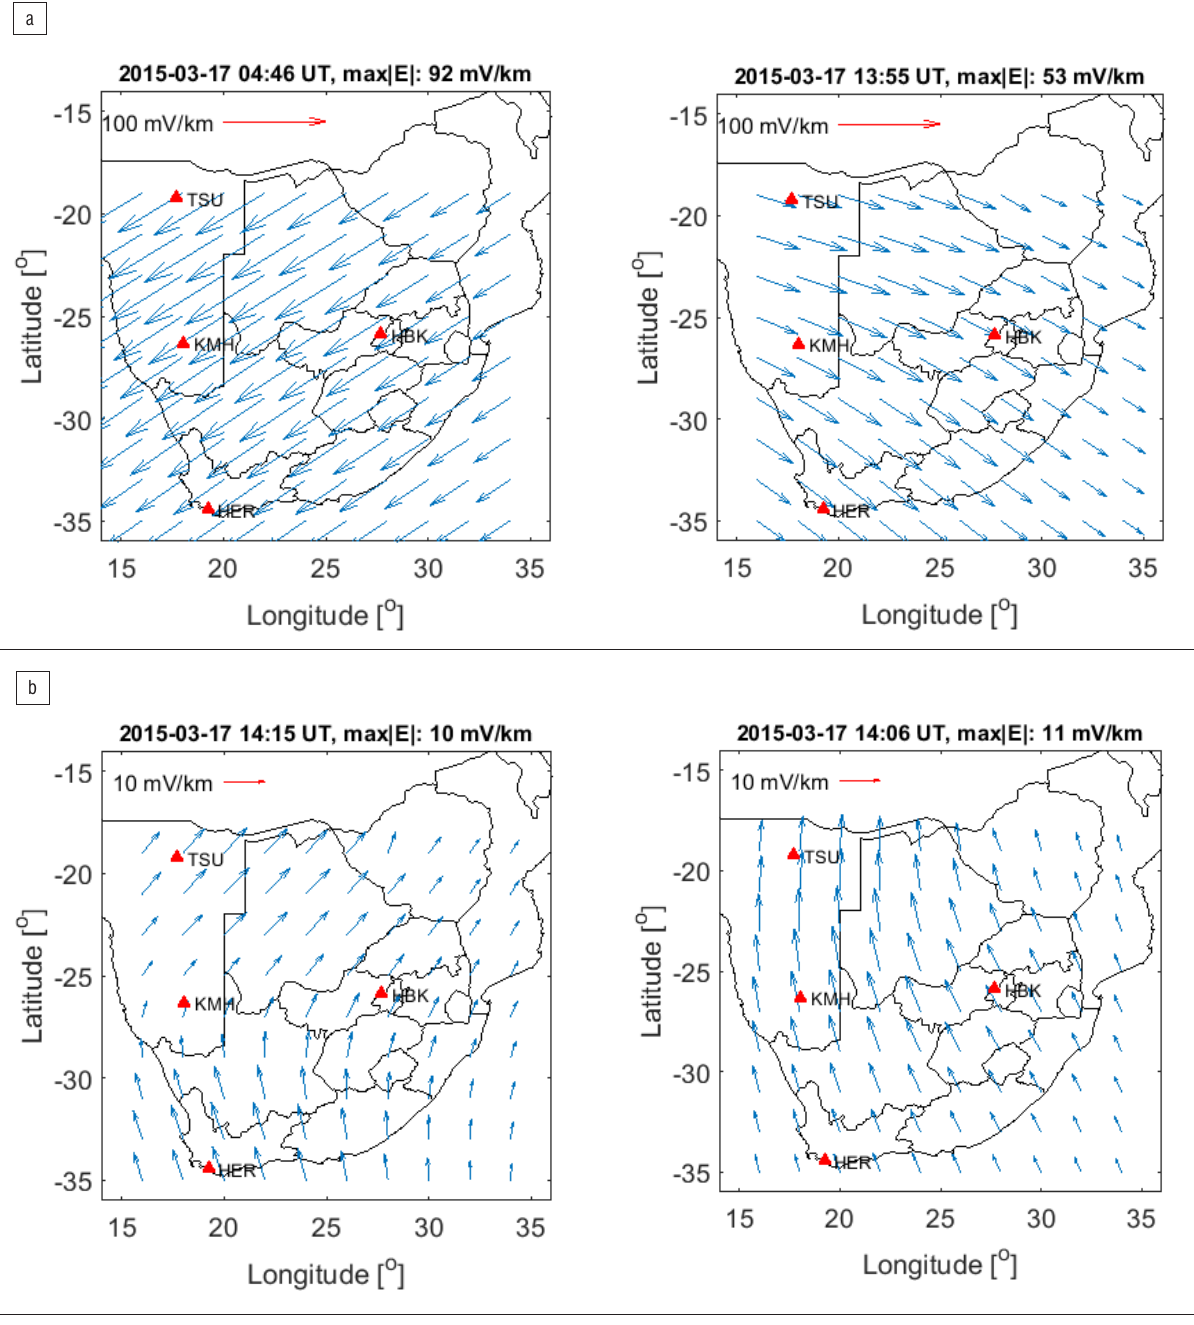
Figure 7: The calculated interpolated horizontal electric field over southern Africa on 17 March 2015 at (a, left) the time when the maximum E-field of 92 mV/km occurred (04:46 UT) and (a, right) the time during the main phase of the storm when the E-field reached 53 mV/km (13:33 UT) and (b) times when there was significant inhomogeneity in the E-field, both in direction and magnitude. The triangles show the locations of the magnetic observatories used to determine the interpolated